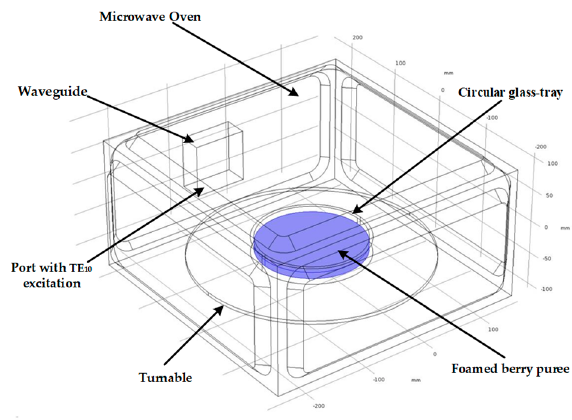
Figure 1. Schematic of the microwave oven .